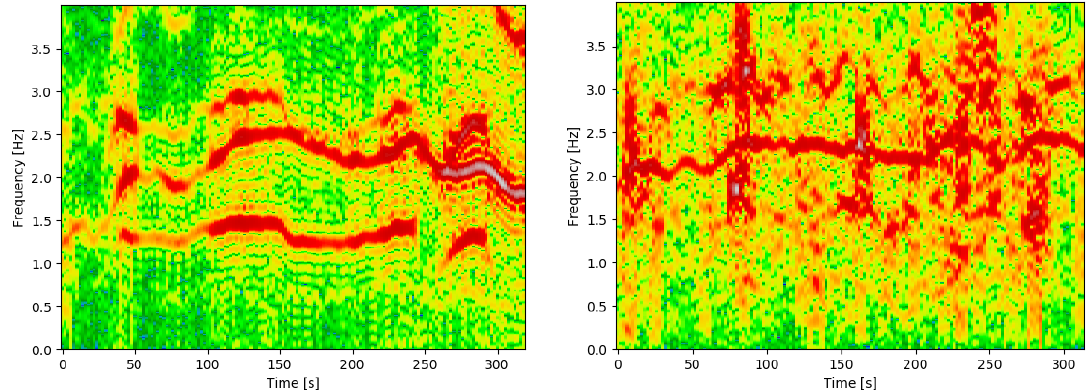
Figure 1. Time-frequency spectra of PPG-signals, derived from the IEEE datasets. Left plot: IEEE_Training dataset, session #8. Right plot: IEEE_Test dataset, session #6 (subject 5, exercise type